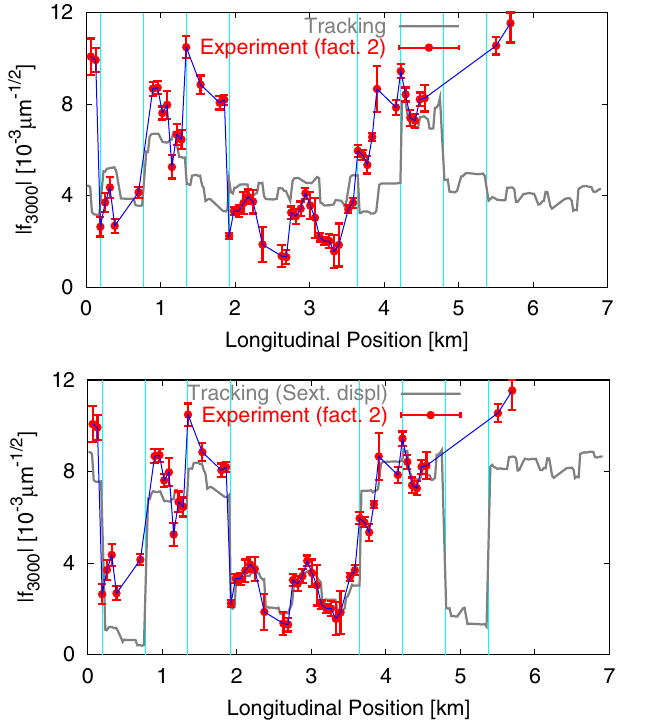
FIG. 16. (Color) Amplitude of the term f versus longitudinal 3000 position with extraction sextupoles on. Top: Experiment and nominal model with decoherence factor. Bottom: Experiment FIG. 17. PSB tune diagram for high intensity and model with displaced sextupoles and decoherence factor. The vertical lines show the position of the extraction sextupoles.